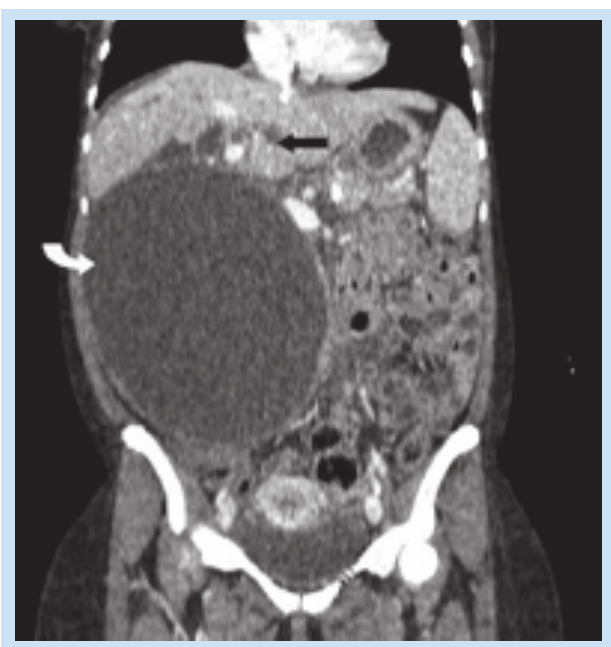
Fig. 1. Coronal reconstruction of multislice CT abdomen demonstrates a massive cystic lesion (curved arrow) at the right inferior border of the